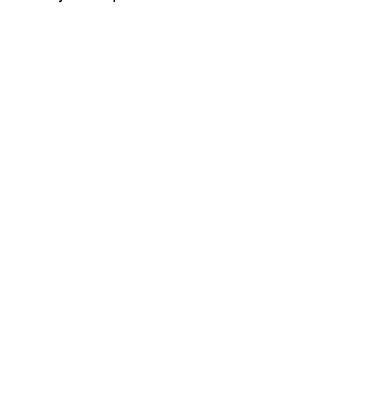
117:225:75 (CC:CT:TT), which is consistent with Hardy – Weinberg equilibrium (p = 0.1833). The minor allele frequency was 45%. The CD14 rs2569190 CC and CT genotypes were pooled together to explore the clinical impact of the TT genotype compared with that of C-allele carri- ers in accordance with our a priori hypothesis (Table 1). The sepsis subtypes included sepsis/ severe sepsis (39%) and septic shock (61%). The morbidity scores, SOFA and APACHE II, at baseline were 9.2±4.0 and 21.5±7.3, respectively (Table 1). The comorbidities included hyper- tension, a history of myocardial infarction, chronic obstructive pulmonary disease (COPD), renal dysfunction, diabetes mellitus, chronic liver diseases, a history of cancer, and a history of stroke (Table 1). Moreover, recent surgical history, site of infection and organ support